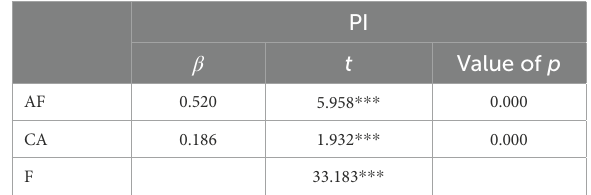
TABLE 8 Significance test of mediating variable to the dependent